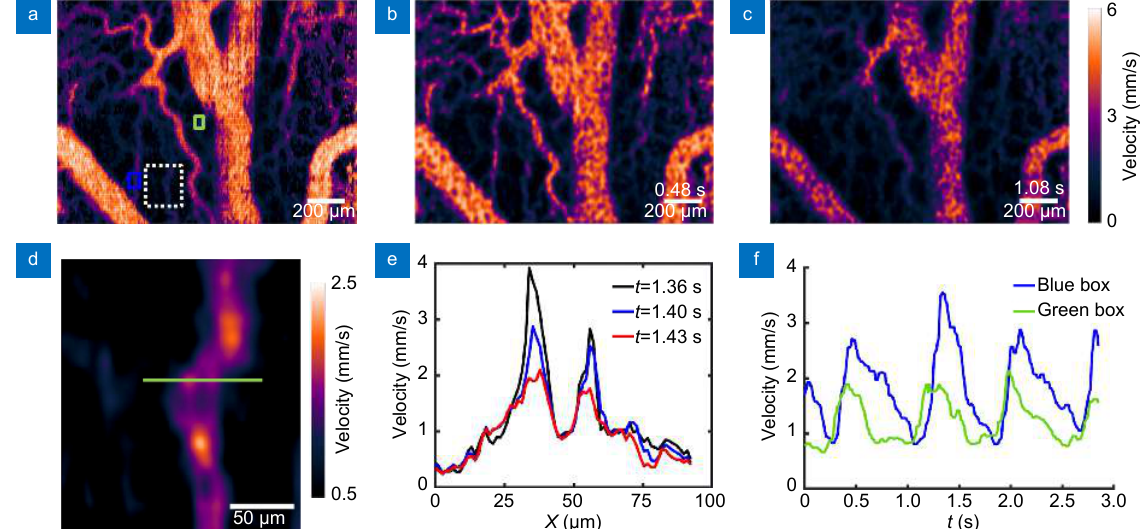
Fig. 2 | Blood flow velocity images obtained from chicken embryo No. 1 using LS-LSAI. ( a ) An averaged blood flow velocity map over the entire image stack. ( b ) An instantaneous blood flow image at the time point 0.48 s, when the flow velocity reached the maximum. ( c ) An instant- aneous blood flow image at the time point 1.08 s, when the flow velocity reached the minimum. ( d ) A magnified view of the white dashed boxed region in (a). ( e ) Cross-sectional flow velocity profiles taken along the green line in (d) at various time points. (f) The time courses of spatially av- eraged blood flow over the regions indicated by the blue and green squares in